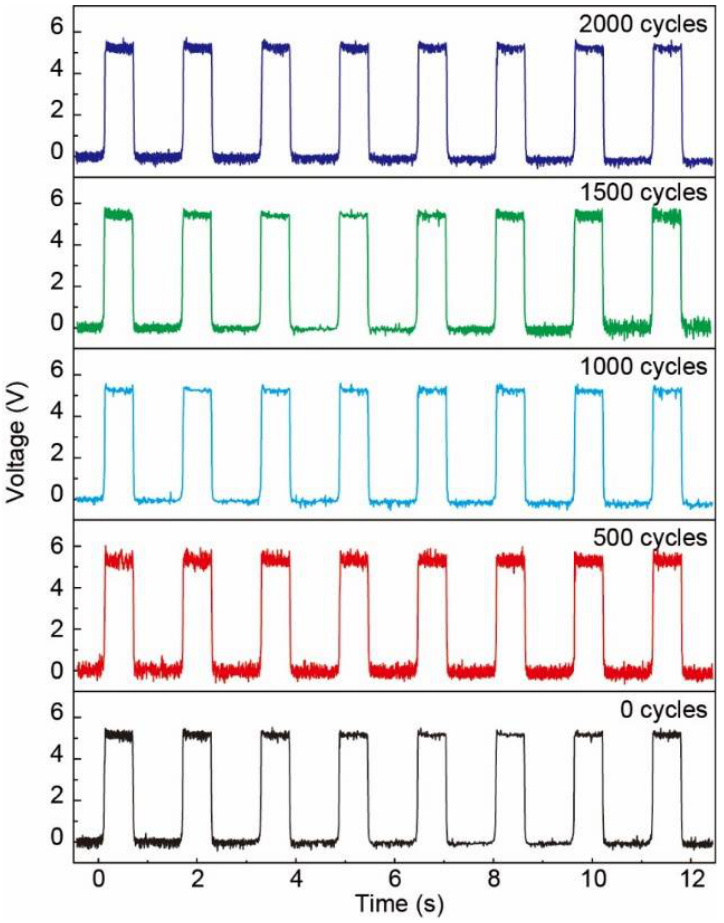
Figure 10. Output voltage for 2000 bending (bending angle: ~30°) cycles to show the mechanical stability of the Ag NFs electrode based pressure sensor array. The output voltage kept at 5–6 V in the bending test.